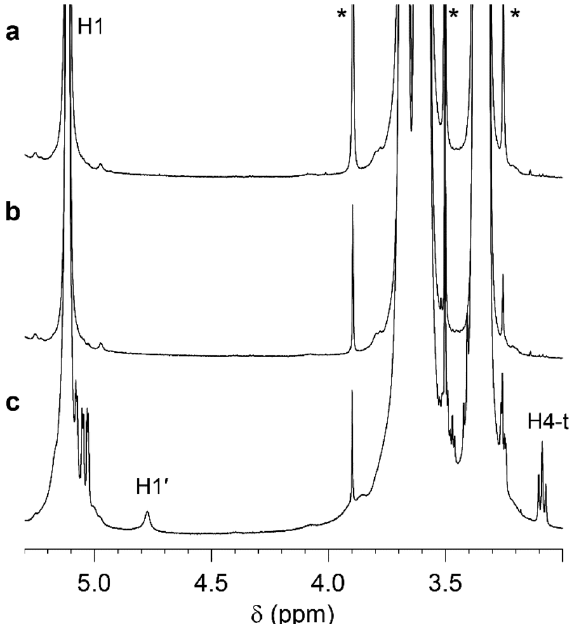
Figure 4. 1 H NMR spectra of starch from the Group 3 lines ( a ) 104010 and ( b ) 104023, and from ( c ) the parental variety Desiree. Glucose H1 at the α(1 → 4)-linkage (H1) and at the α(1 → 6)-linkage (H1 ′ ) are assigned as well as H4 of non-reducing end terminal residues (H4-t). Traces of EDTA and Tris are highlighted with